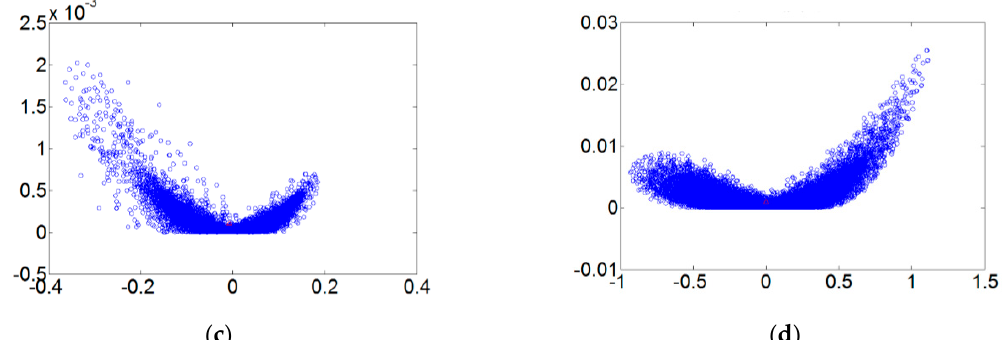
Figure 5. The order 1 fault dynamic error trace diagrams for all fault diameters. ( a ) Normal state; ( b ) fault diameter = 0.007; ( c ) fault diameter = 0.014; ( d ) fault diameter = 0.021.